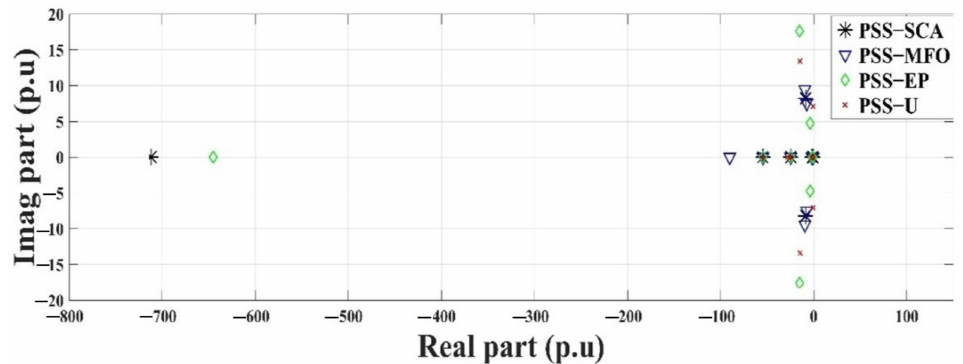
Figure 10. Eigenvalue’s location on the complex s-plane for loading condition 3 of the SMIB with PSS.